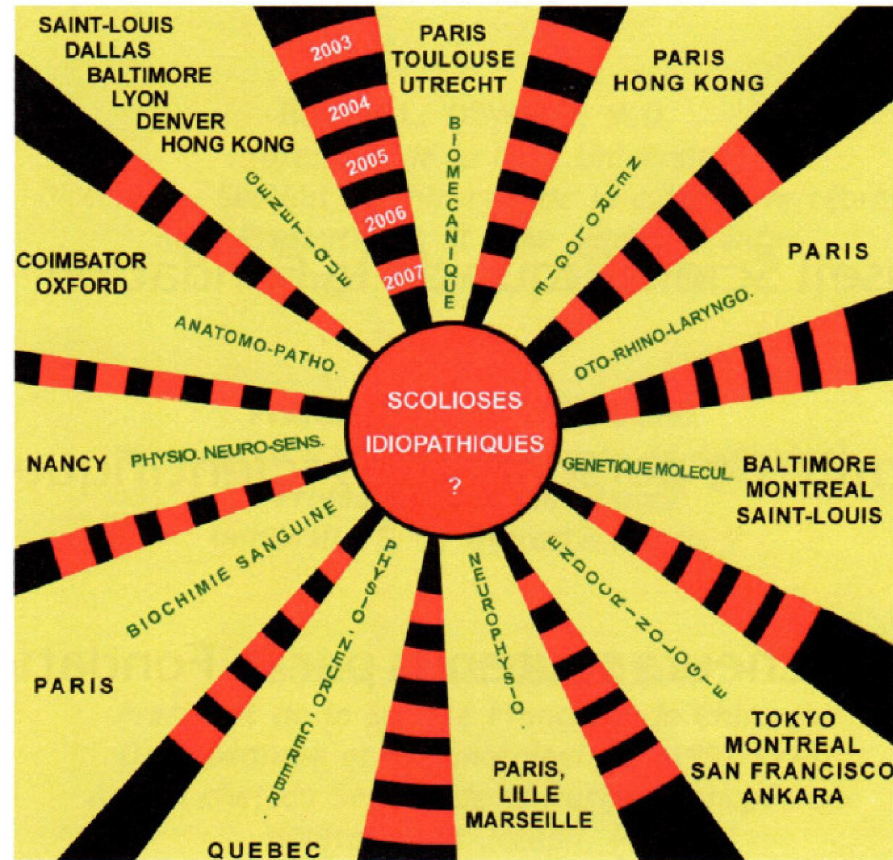
Figure 1. In 2007, Dr. Cotrel and team listed 10 potential categories of underlying causes of